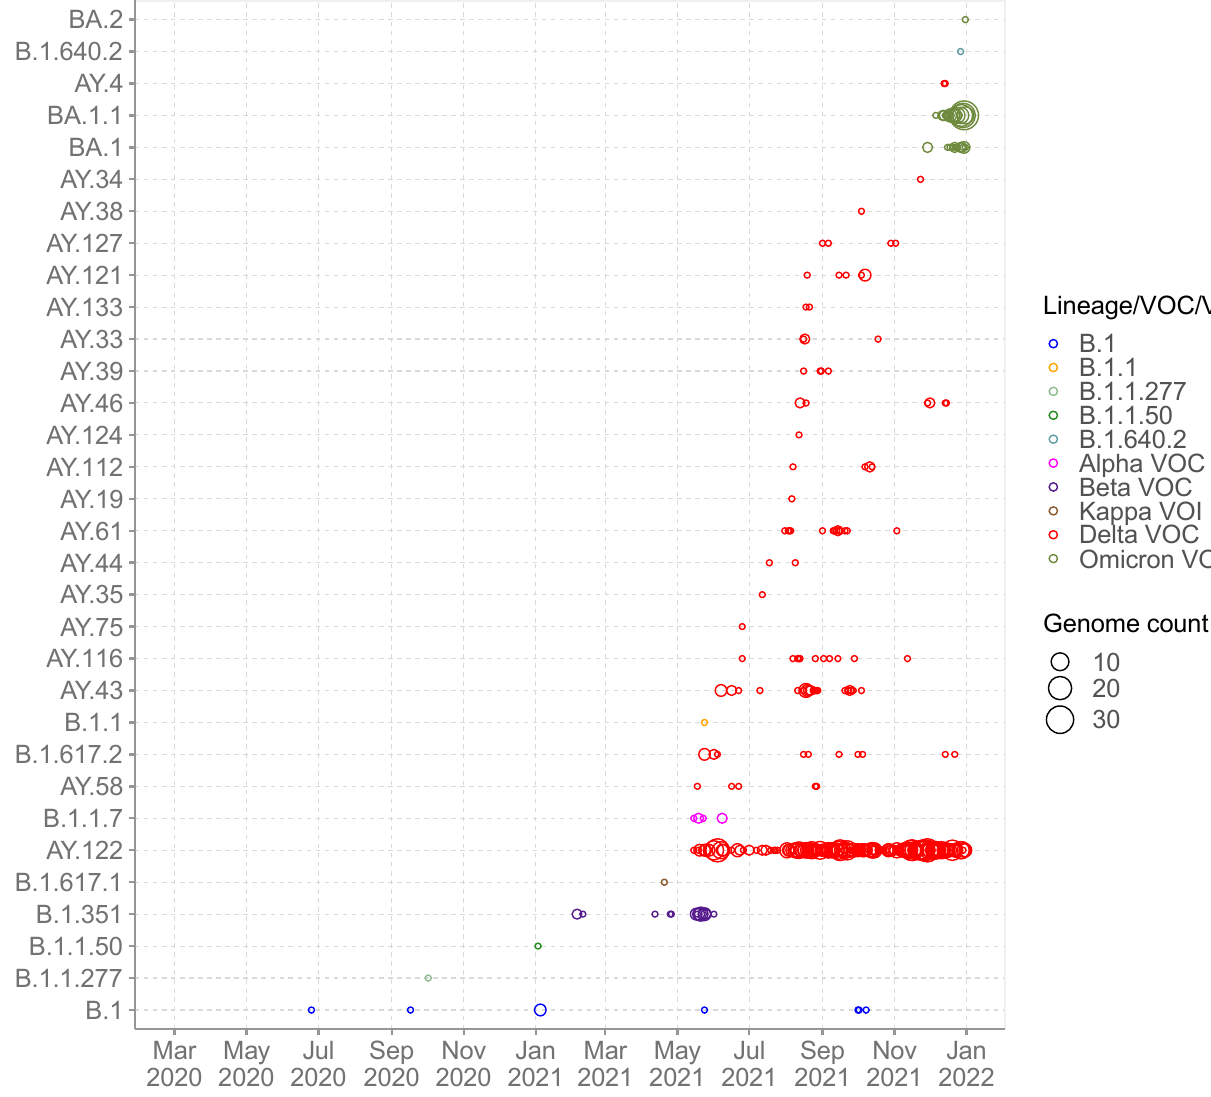
Figure 2. SARS-CoV-2 Pango lineages in the sequenced 1056 Seychelles samples and timing of detections (circle size scaled by number of daily detections).